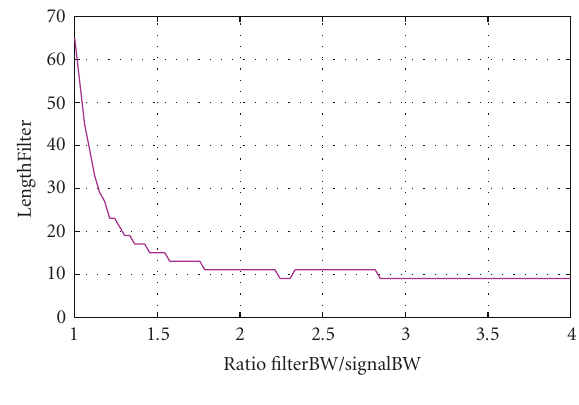
Figure 8: Filter length